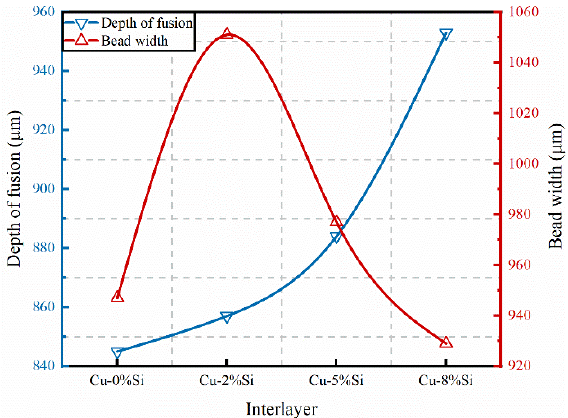
Figure 5. Curves of the melting depth and melting width with different Si content.